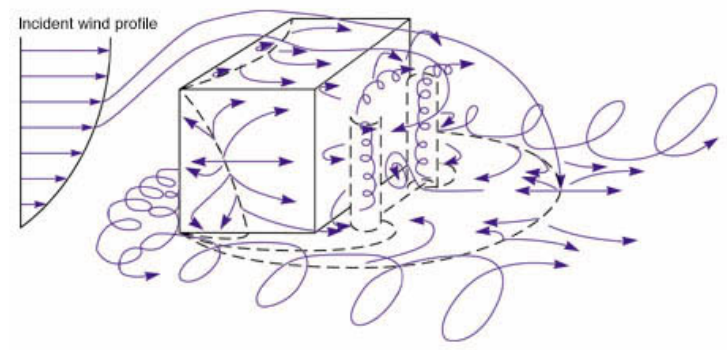
Figure 3. Conceptual representation of the flow around a building. Image courtesy of Laboratory LLN.